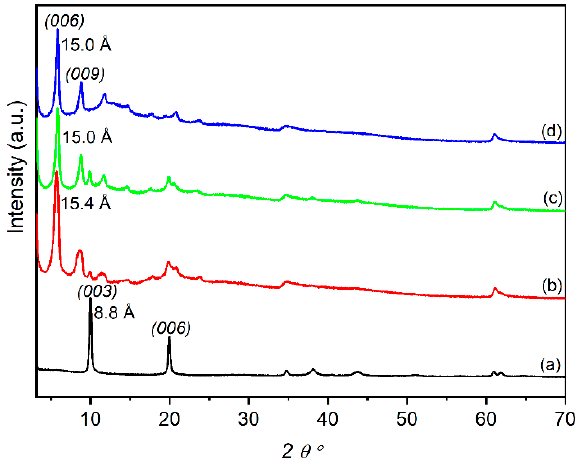
Figure 1. X-ray diffraction patterns of LDH-NO 3 ( a ) and of MgAl-O ( b ), MgAl-L ( c ) and MgAl-Ln ( d ) prepared in H 2 O/EtOH as solvent.